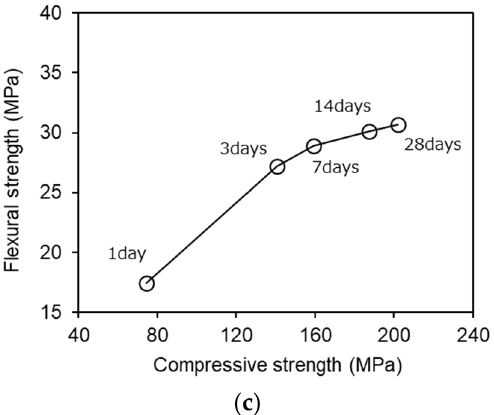
Figure 30. Compressive and flexural strengths of UHPFRC. ( a ) Compressive strength. ( b ) Flexural strength. ( c ) Flexural strength – compressive strength.